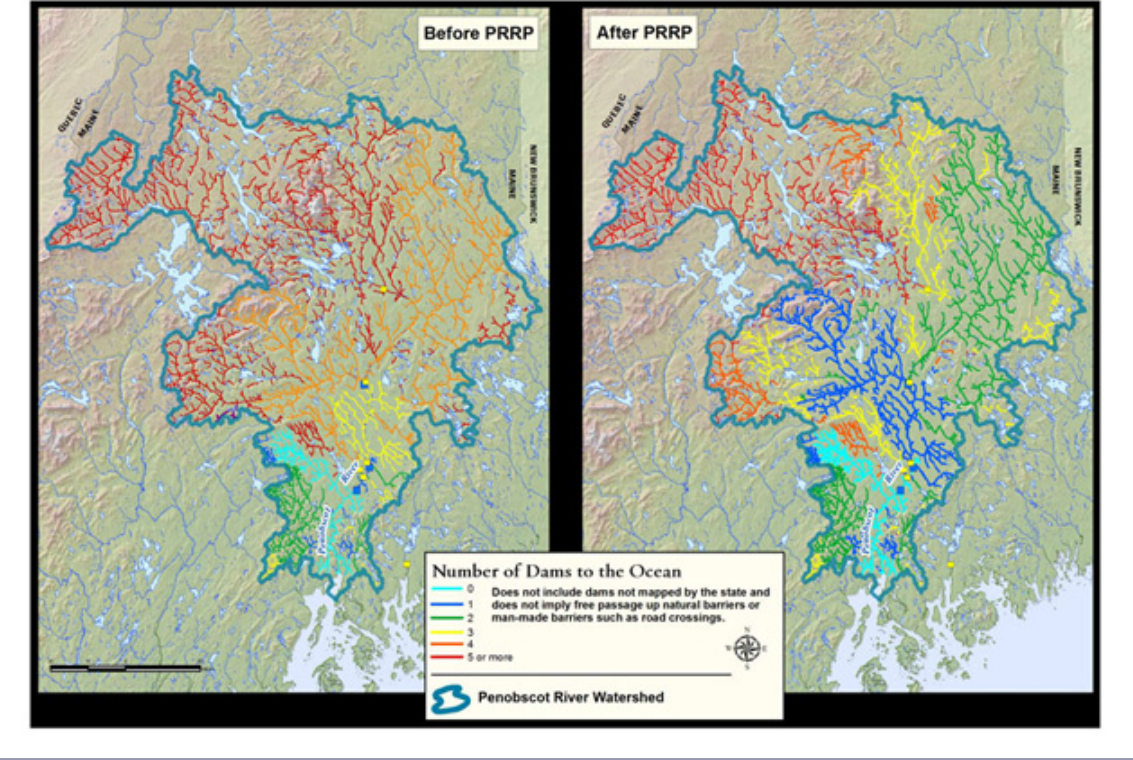
Fig. 5. Fish passage scenarios before and after the Penobscot River Restoration Project. Reaches and tributaries are color-coded to represent how many dams lie between them and the ocean. A key feature of the Project is providing state-of-the-art fish passage at the mainstem dams that will remain after project